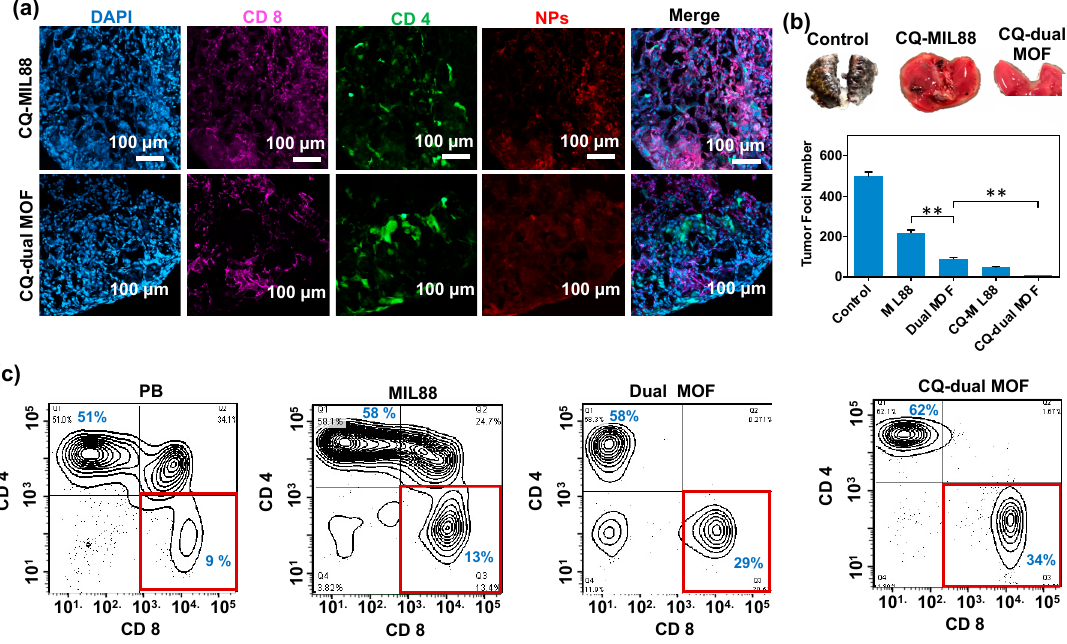
Figure 7. In vivo study of mice bearing B16F10 lung metastases treated with CQ-MIL88 and CQ- dual MOF. ( a ) CLSM images of lung metastases treated by CQ-MIL88 and CQ-dual MOF. ( b ) Images of dissected lung metastases treated by PBS (control), CQ-MIL88, and CQ-dual MOF. ( c ) Patterns of flow cytometry showing the CD4 + and CD8 + expression of T cells in lungs after various treatments. Quantitative significant statistical data were calculated via Student’s t -test, ** p <